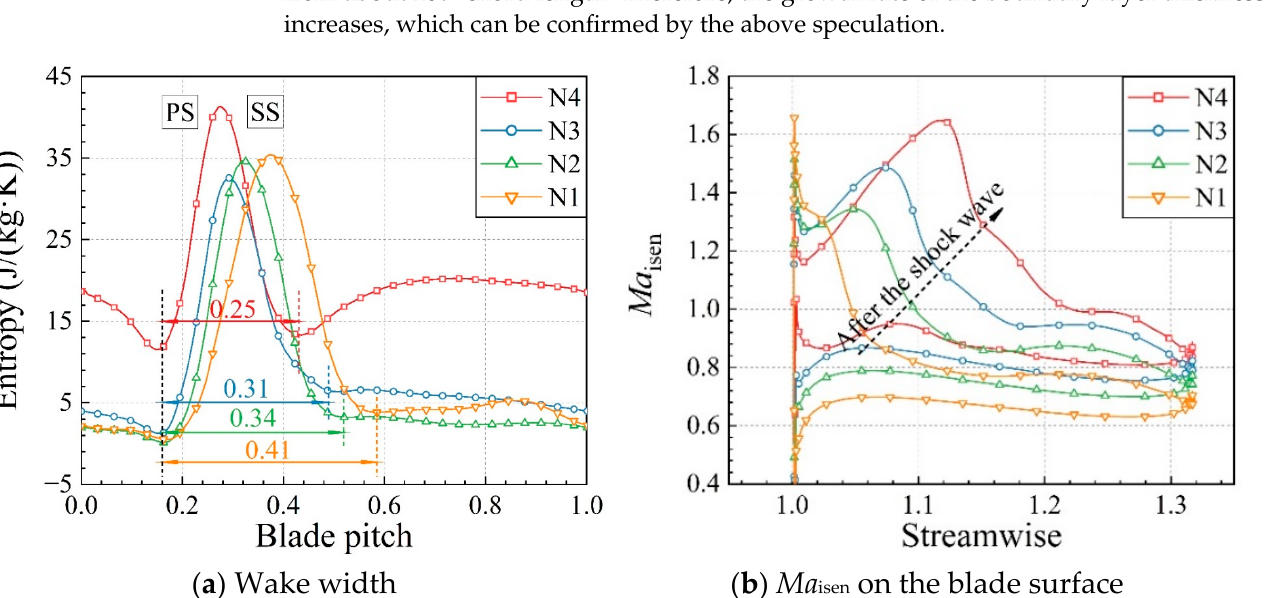
Figure 19. Ma re and entropy contour at 75% span of the tandem rotor.